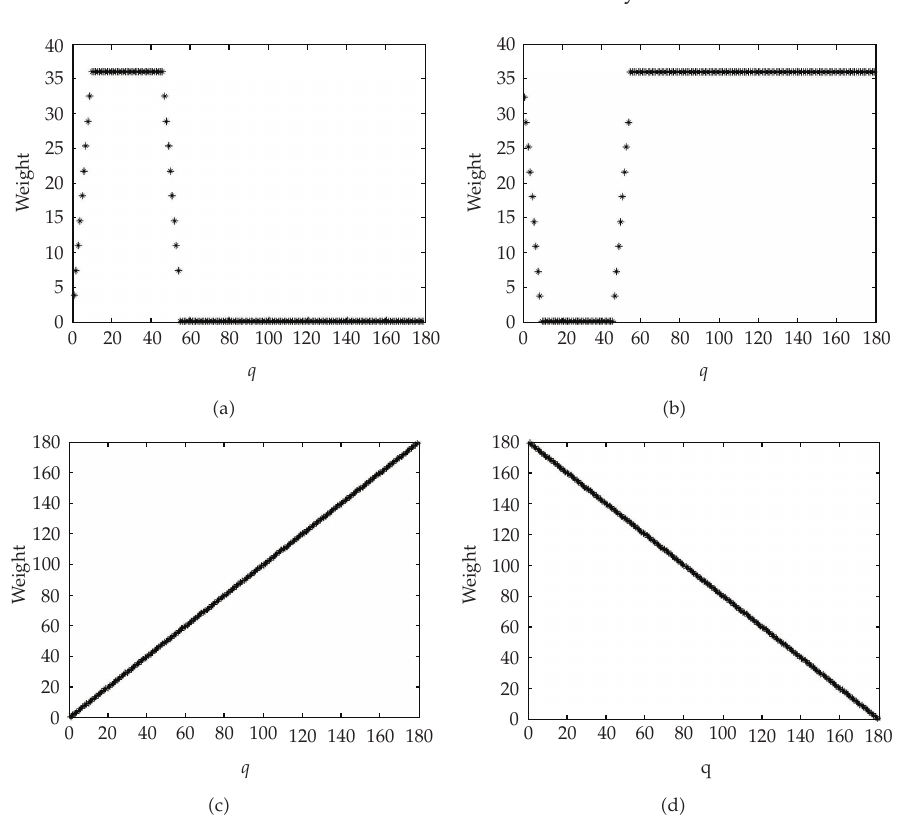
Figure 9: Di ff erent weighting functions: (cid:2) a (cid:3) the proposed EWF, (cid:2) b (cid:3) InverseEWF , (cid:2) c (cid:3) Uplinear , and (cid:2) d (cid:3)